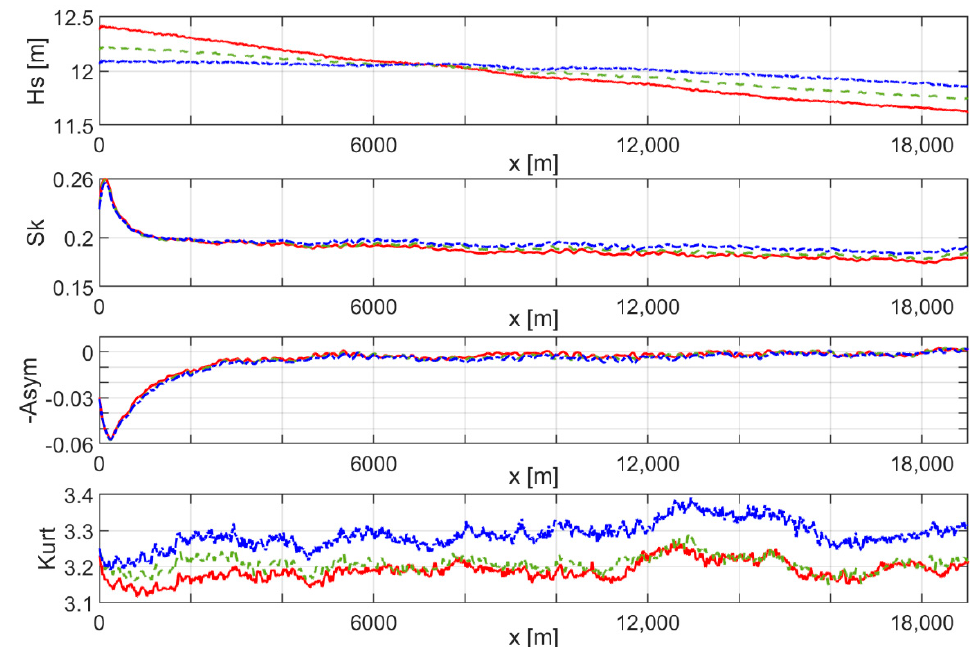
Figure 20. Longwave statistics over the simulation interval for 1D simulations without breaking (blue solid), for U/C= 0.9 (green dashed), and for 0.8 (red dotted); the curves for Skewness and Asymmetry have been smoothened, with a factor of 100, for better comparison.